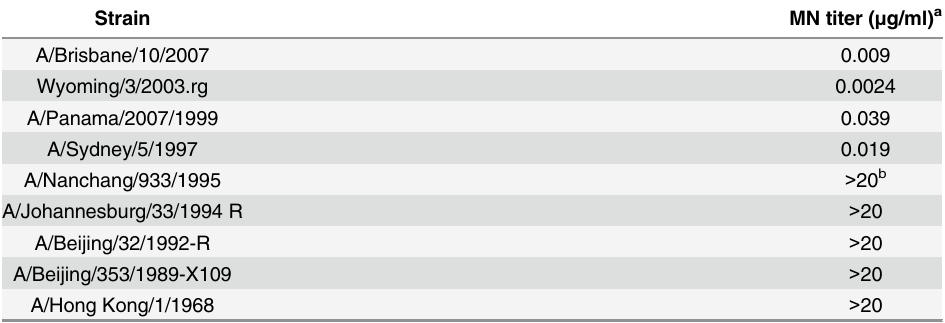
a MN (microneutralization) titers are expressed as the lowest concentration of puri fi ed CT302 IgG completely neutralized the in fl uenza virus. b No detectable neutralization activity at the concentration of 20 μ